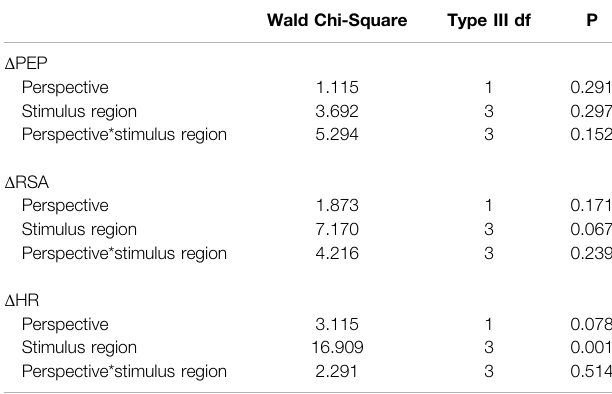
TABLE 1 | Results of exchangeable correlation generalized estimating equation for physiological measurements from baseline to pain provocation.